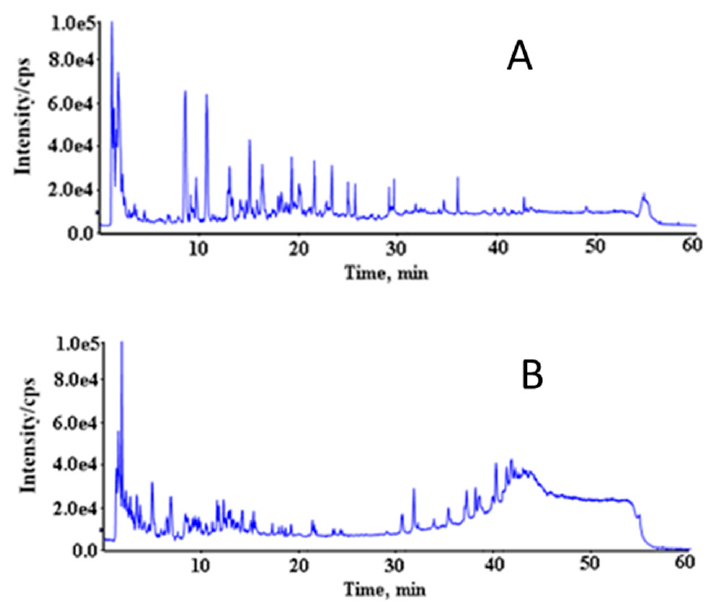
Figure 3. Typical chromatograms—total ion chromatogram (TIC) of a rat’s urine sample by LC-QTOF-MS, in positive ion mode ( A ) and negative ion mode ( B ).